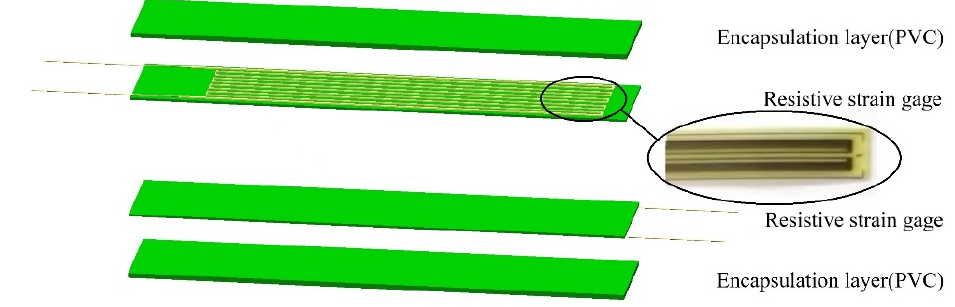
Figure 1. Flexible angle sensor structure diagram.